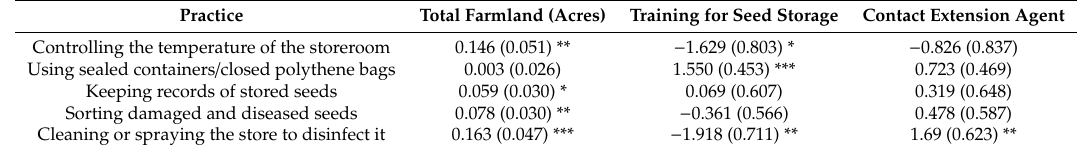
Table 5. Knowledge-based awareness of growers for seed storage (N =